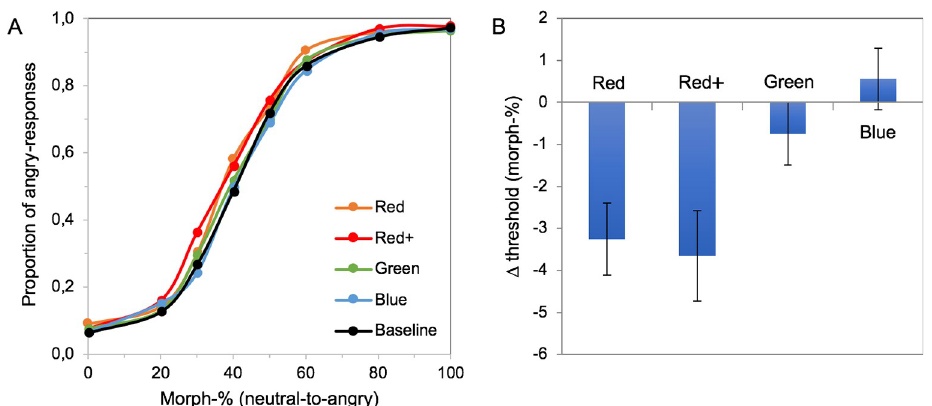
Fig 6. The effect of background color on anger perception. (A) Psychometric functions showing anger recognition performance as a function of morph level for each background condition, averaged across 20 participants. (B) Average color-induced change in the 50% threshold for each background color. Error bars represent +/- 1 standard error of the mean.